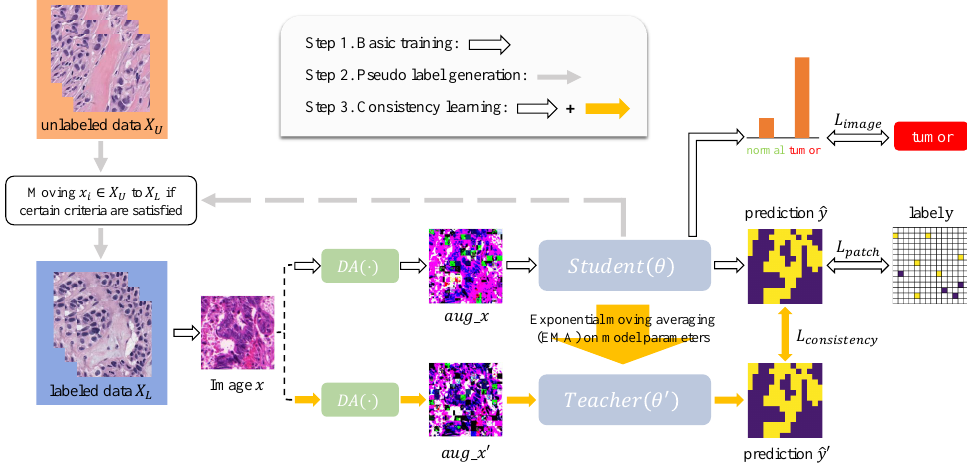
Figure 2. Overview of the framework for training PSeger. DA ( · ) indicates data augmentation